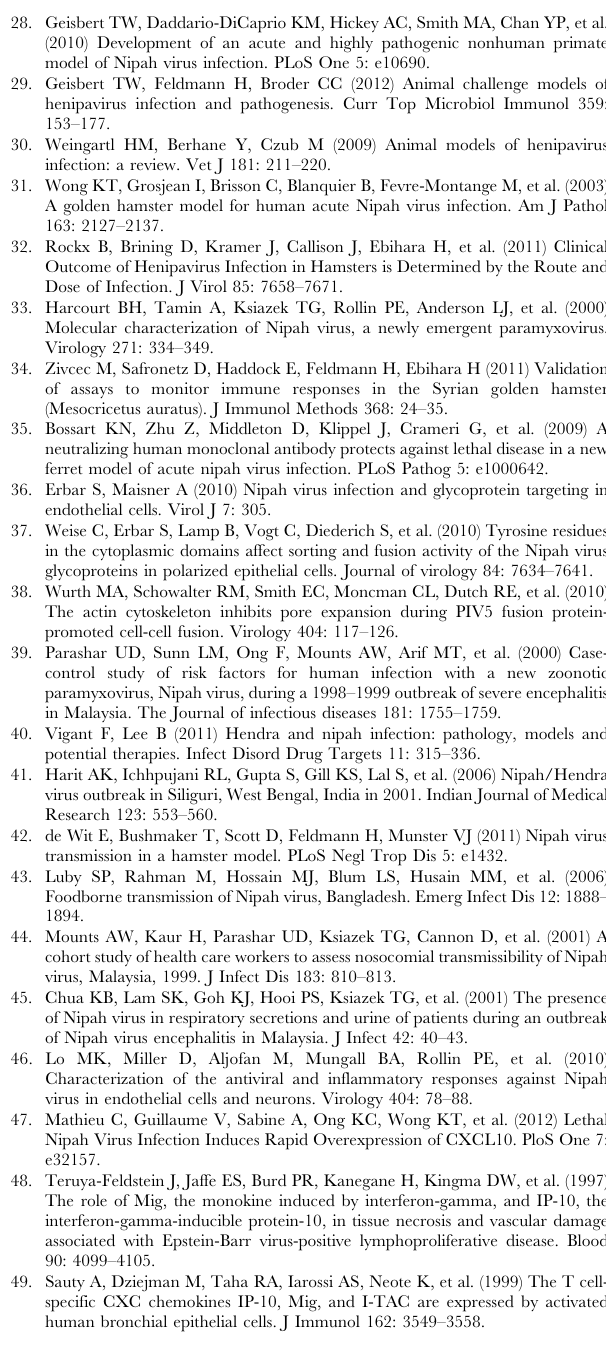
Figure S1 Hamsters inoculated intranasally with NiV-B show delayed disease progression compared to NiV-M- inoculated hamsters. Groups of 5 hamsters were inoculated i.n. with 10 5 TCID 50 . The hamsters were monitored for survival. A log- rank test was used to compare survival curves (*= p , 0.05). NiV-B infected animals had a mean time to death of 11.6 days and NiV-M infected animals 9.4 days.